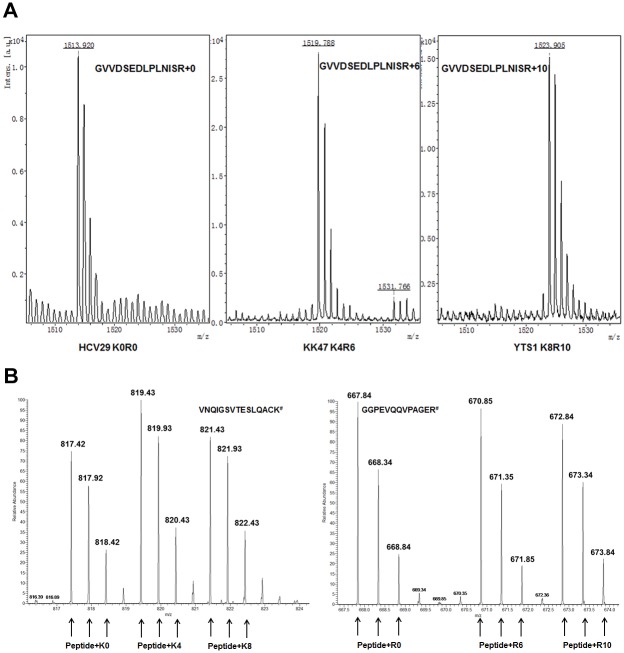
Mass spectrometric analysis of stable isotope-labeled proteins (SILAC method).(A) Determination of incorporation efficiency by MALDI-TOF/TOF-MS. Peaks annotated as R0 (left), R6 (middle), and R10 (right) are peptide GVVDSEDLPLNISR of heat shock protein 90 from HCV29, KK47, and YTS1 cells. (B) Identification and quantification of proteome in BC cells by 2D-HPLC LTQ Orbitrap MS. Peaks annotated as K0, K4, and K8 (left) and R0, R6, and R10 (right) are doubly charged peptide VNQIGSVTESLQACK of alpha enolase and GGPEVQQVPAGER of fatty acid synthase.